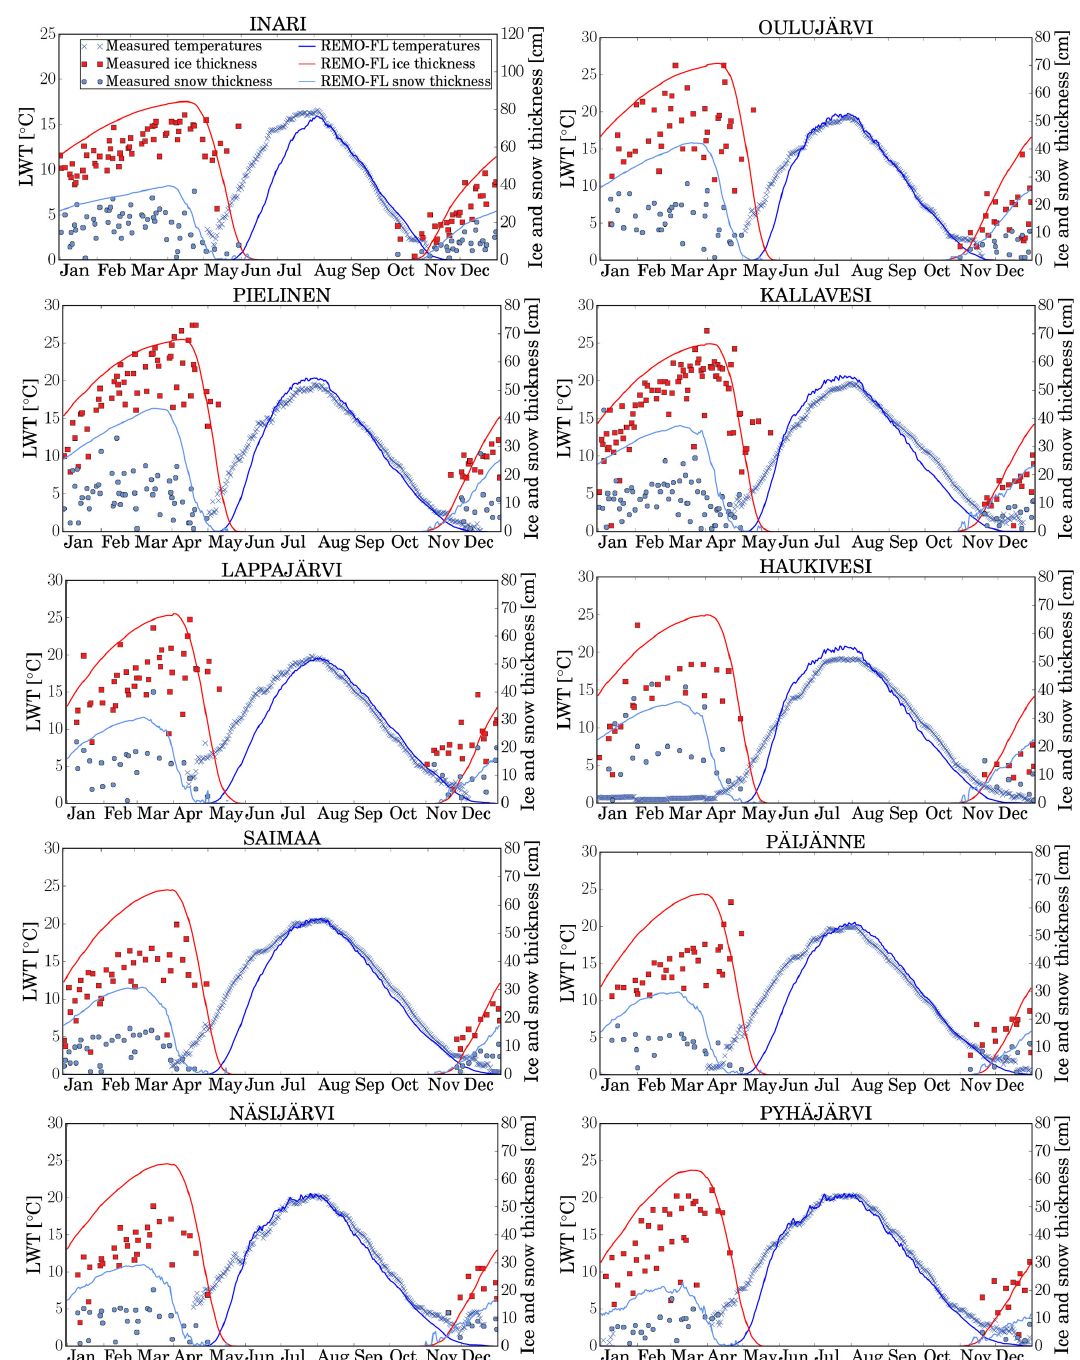
Figure 6. The measured and modeled daily averaged lake water temperatures (LWTs), ice thicknesses and the amount of snow on ice. The values have been averaged for the time period of October 1979–March